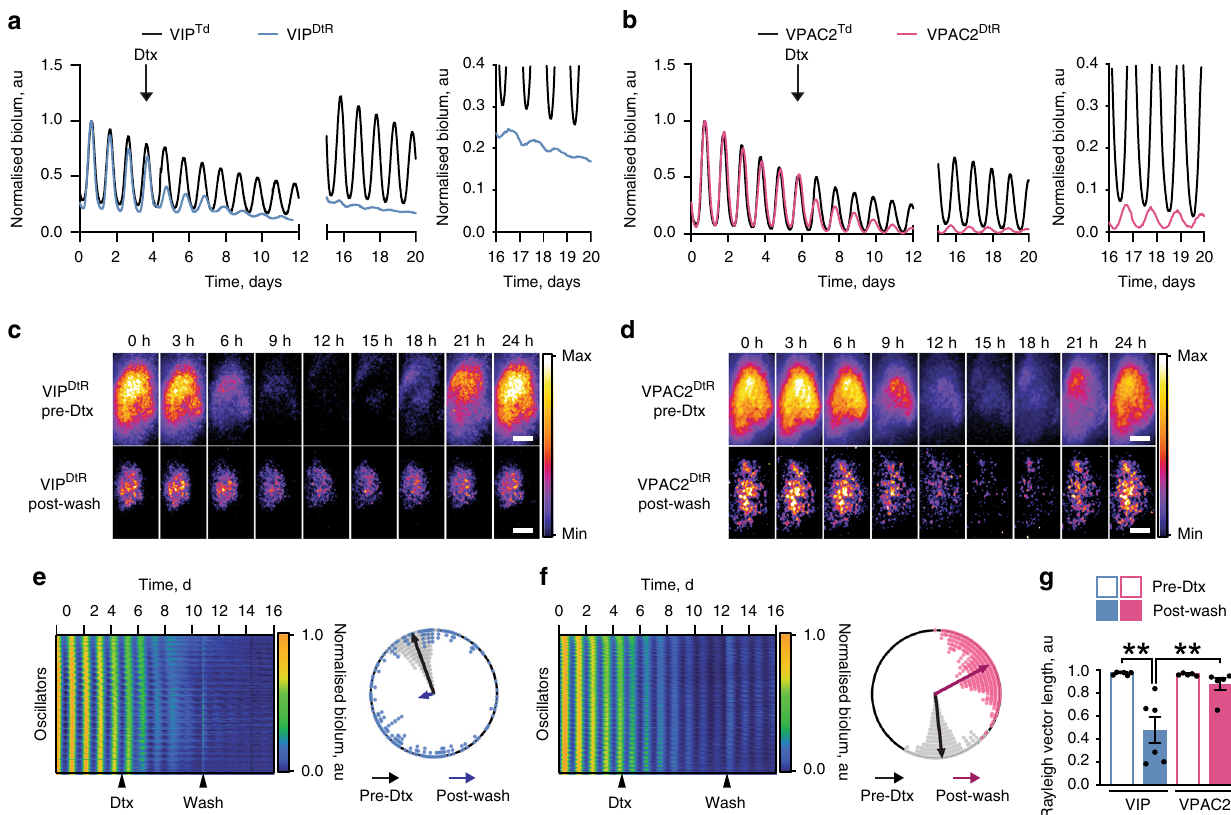
Fig. 4 Differential contributions of VIP cells and VPAC2 cells to SCN circuit-level function revealed by their speci fi c toxin-mediated ablation. a , b Representative normalised Per2::Luciferase traces for ( a ) VIP Cre SCN and ( b ) VPAC2 Cre SCN conditionally expressing either TdTomato (Black) or the diphtheria toxin receptor (DtR) (VIP Cre : blue, VPAC2 Cre : pink). The traces show ongoing ensemble oscillation before, during and after wash-out of diphtheria toxin (Dtx) addition, and the insets to the right show expanded views of the oscillations post-washout. c , d Bioluminescent micrographs of a single cycle of bioluminescence for ( c ) VIP DtrR and ( d ) VPAC2 DtR SCN before addition of Dtx (upper) and post-washout (lower). Scale bars = 100 µ m. e , f Raster plots showing cellular bioluminescence intensity through time for ( e ) VIP DtR and ( f ) VPAC2 DtR SCN recordings conditionally expressing DtR before, during and after addition of Dtx. Alongside are representative Rayleigh plots of the corresponding slices showing phase-coherence before addition of Dtx (black) and post-washout (VIP Cre : blue; VPAC2 Cre : pink). Individual points represent individual oscillator circular phases; arrows represent mean circular phase for the slice and condition. g Summary Rayleigh vector lengths before Dtx treatment (hollow bars) and post-washout (solid bars) for VIP Cre (blue, n = 6) and VPAC2 Cre (pink, n = 5) SCN conditionally expressing DtR (** p < 0.01). Individual points represent individual slice values; bars represent mean ± SEM. Statistics: g repeated-measures two-way ANOVA with Sidak ’ s correction for multiple comparisons. Only signi fi cant comparisons ( p < 0.05) are shown. Source data are provided as a source data fi